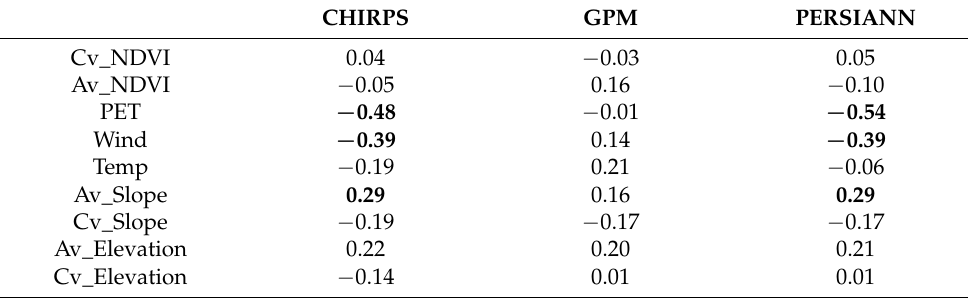
Table 7. Correlation between absolute errors and ecological variables